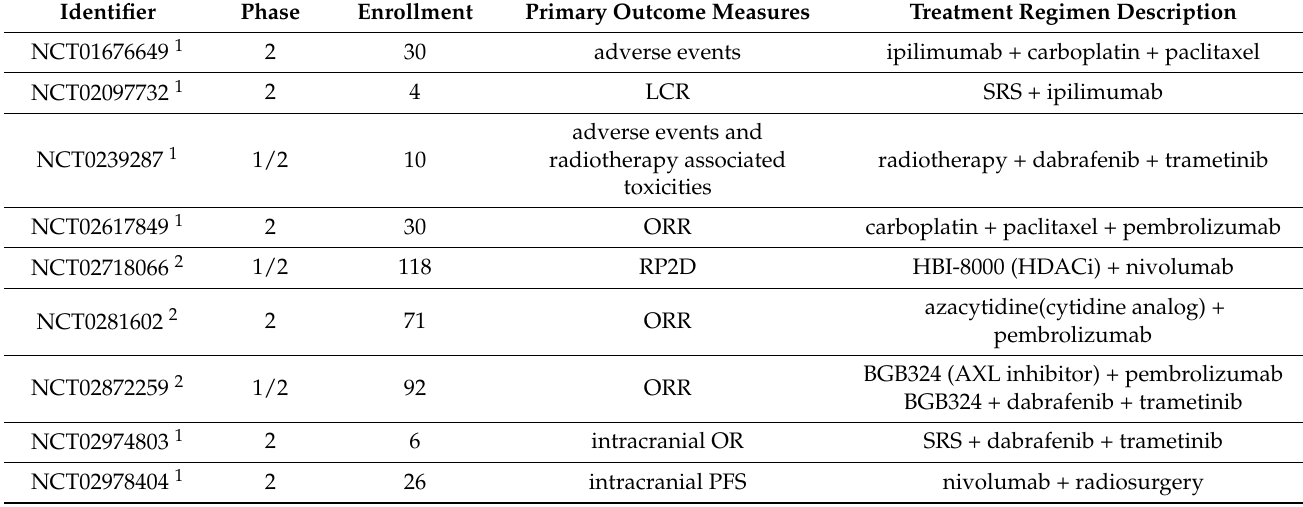
Table 1. Ongoing clinical trials in the treatment of melanoma that combine MAPK inhibitors or immune checkpoint inhibitors with chemotherapy, radiotherapy or drugs targeting proteins of relevance to genome